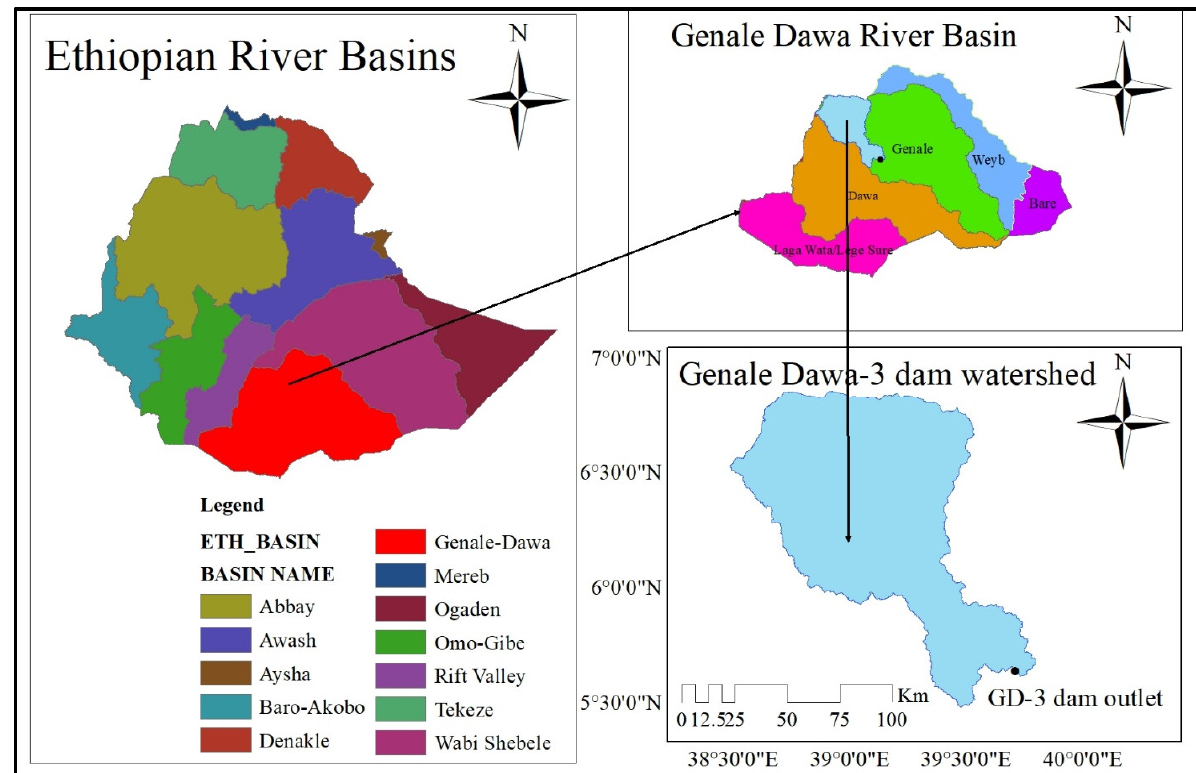
Figure 1. Map of the study area .